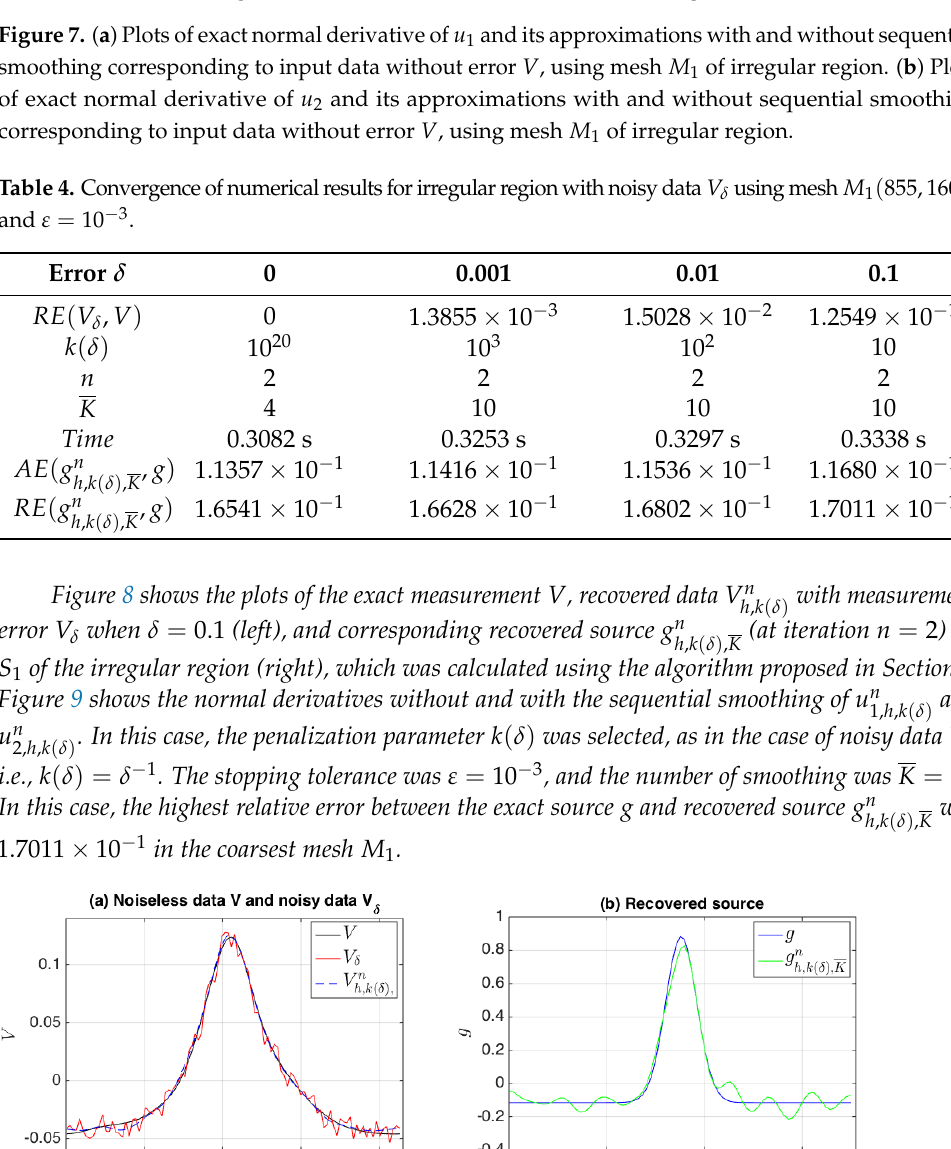
h , k ( δ ) (green) on S 1 , h , k ( δ ) , K